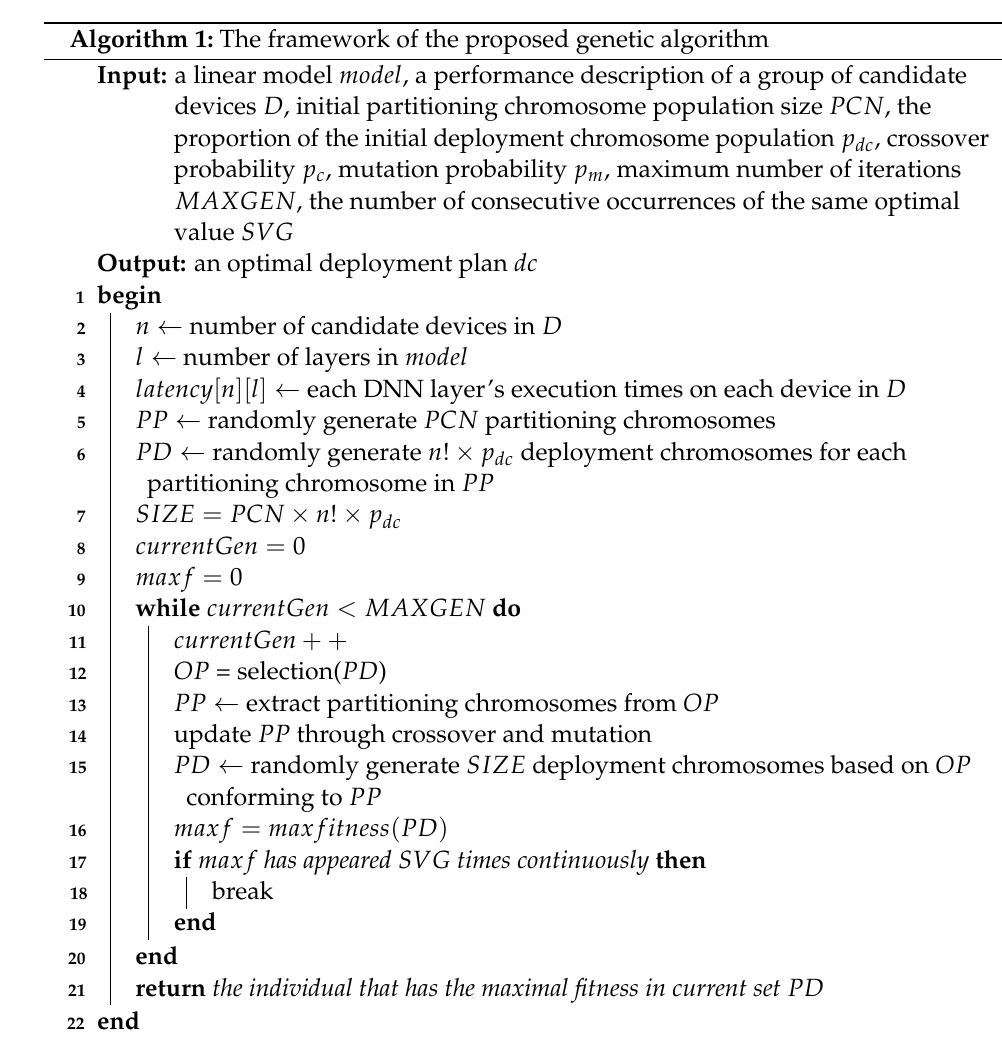
Algorithm 1: The framework of the proposed genetic